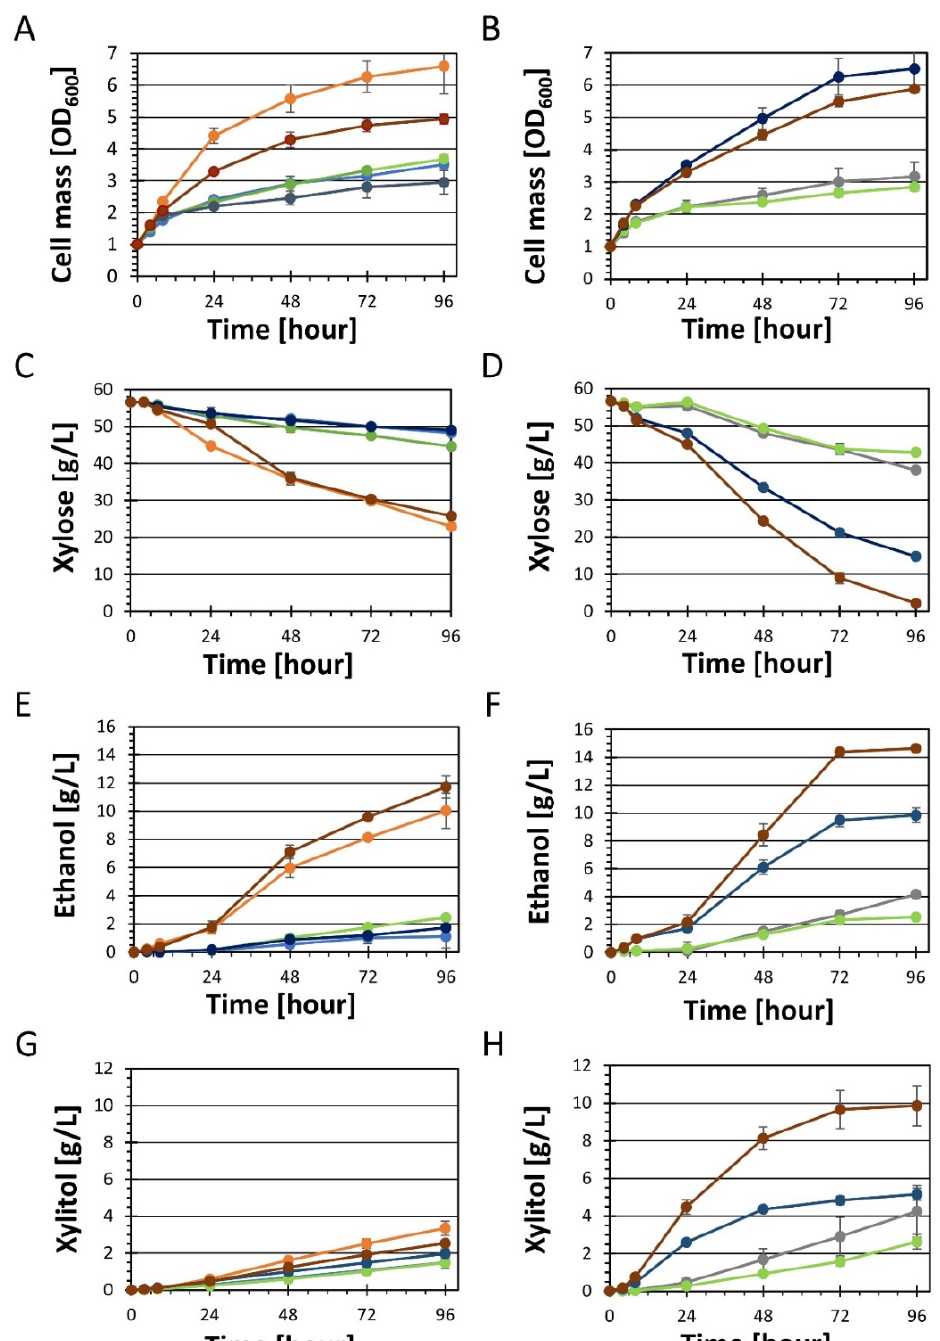
Figure 7. Fermentation analysis for strains with PBS2 and PHO13 deletions. ( A , C , E , G ) CEN.PK2-1C cells expressing P. ruminicola XI/XK genes. ( B , D , F , H ) CEN.PK2-1C expressing the S. stipitis XYL1 and XYL2 , and ScXYKS1 genes. YP5X medium was used for all fermentations. Plots are the average values from three biological replicate cultures. Error bars show standard deviations. Strain description: Panels ( A , C , E , G )